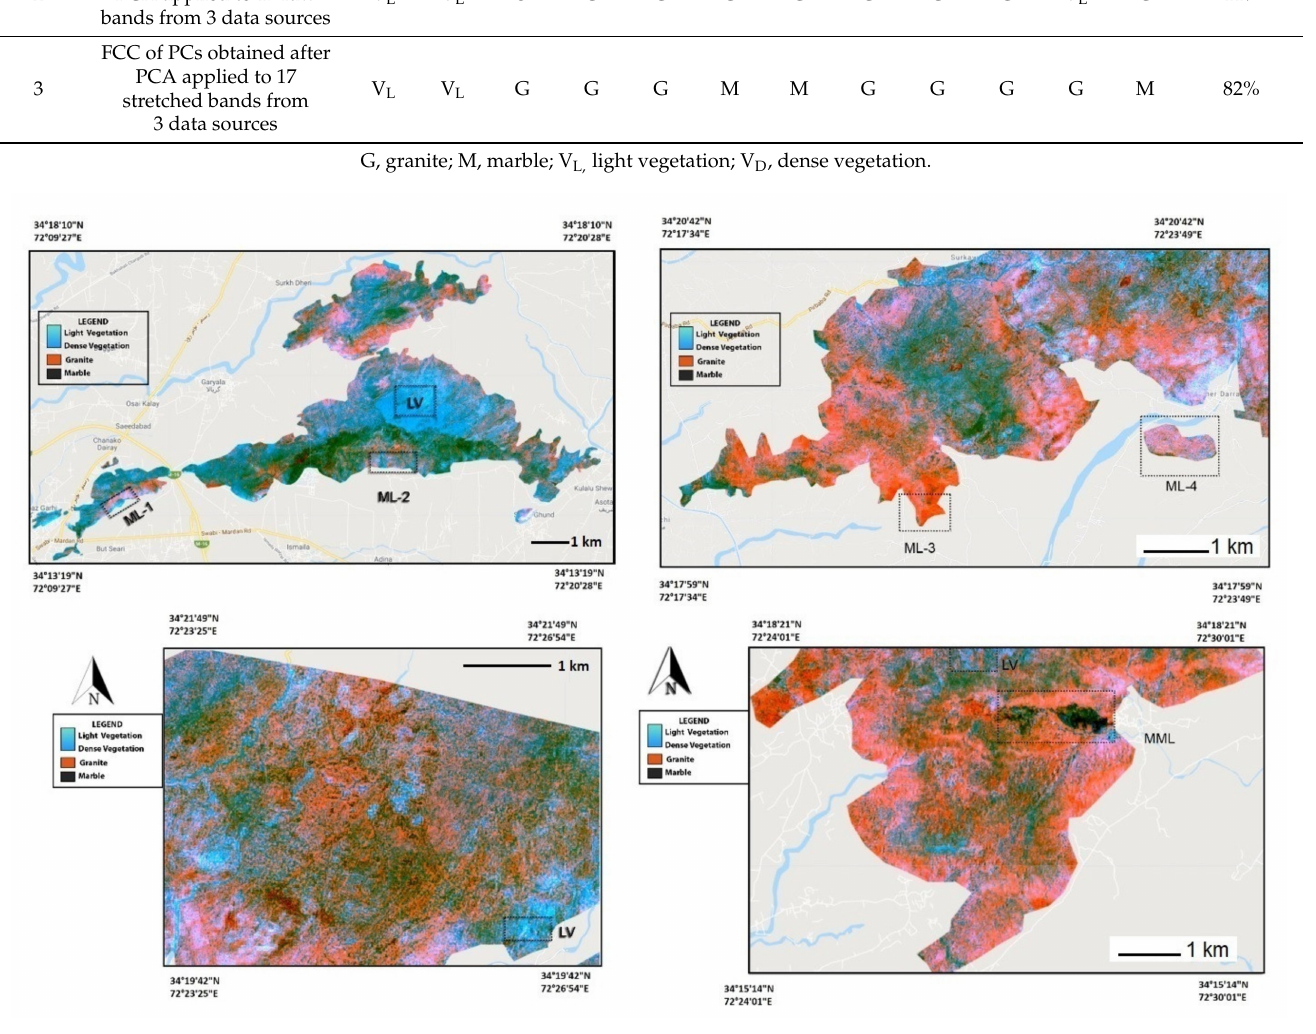
Figure 12. Zoomed-in areas of the study region showing MMLs and granite leases (ML-1–ML4) amongst low vegetated (LV)